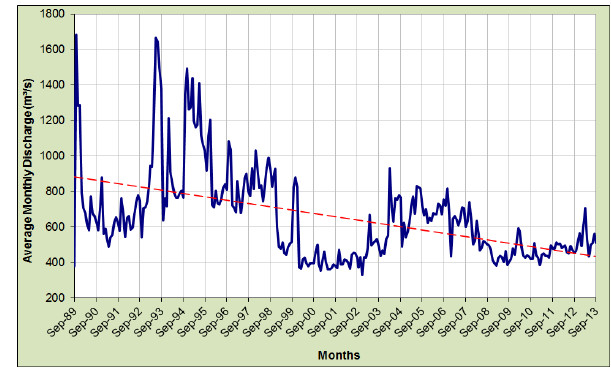
Figure 5. Decadal hydrographs of River Tigris at Sarai Baghdad for the period 1930-2013. Figure 5: Decadal hydrographs of River Tigris at Sarai Baghdad for the period 1930–2013.